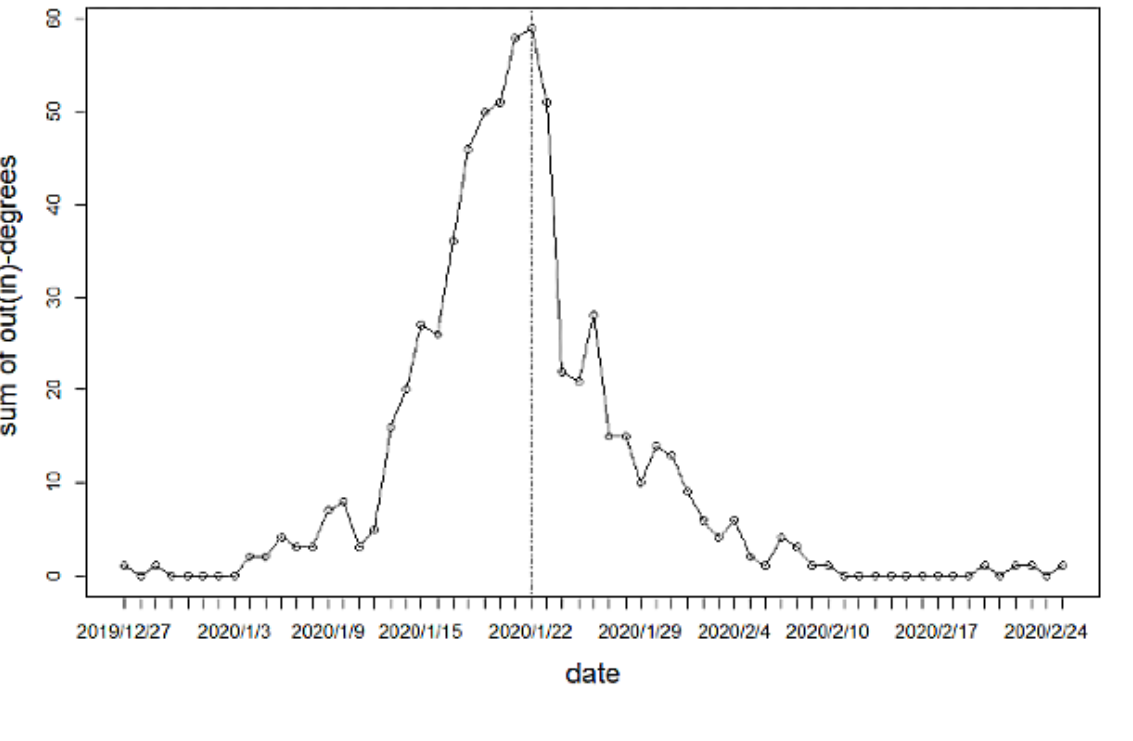
Figure 4. Evolution of the sum of the out-degrees (in-degrees) in the COVID-19 epidemic network for each